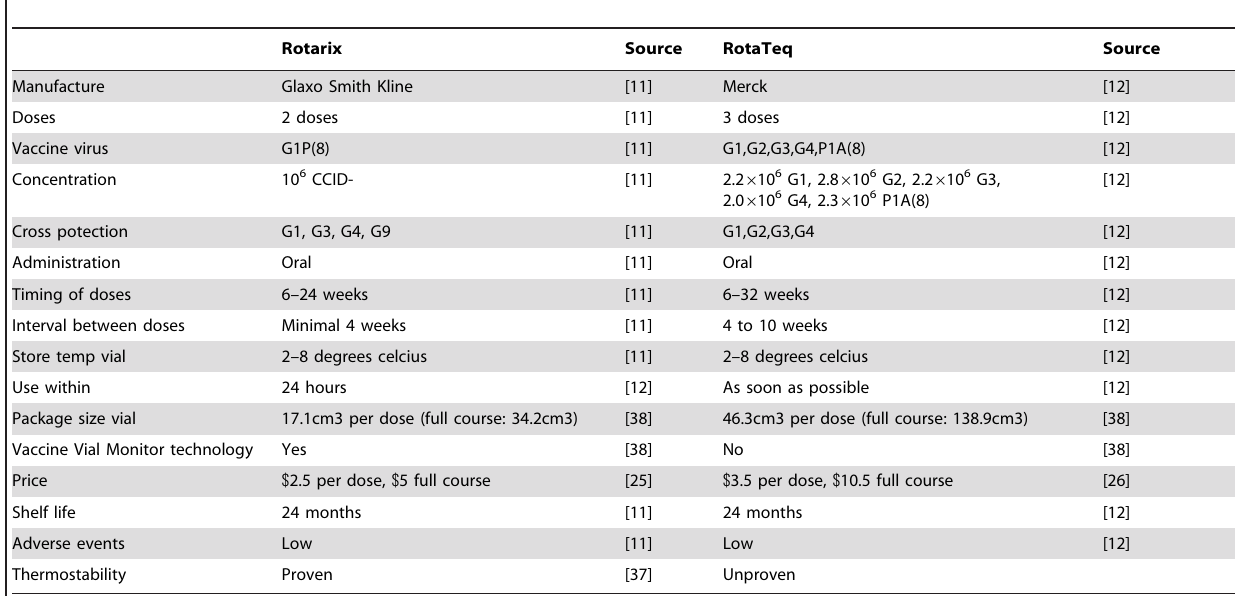
Table 1. Characteristics of Rotarix and RotaTeq vaccines for the prevention of rotavirus associated diarrhoea.